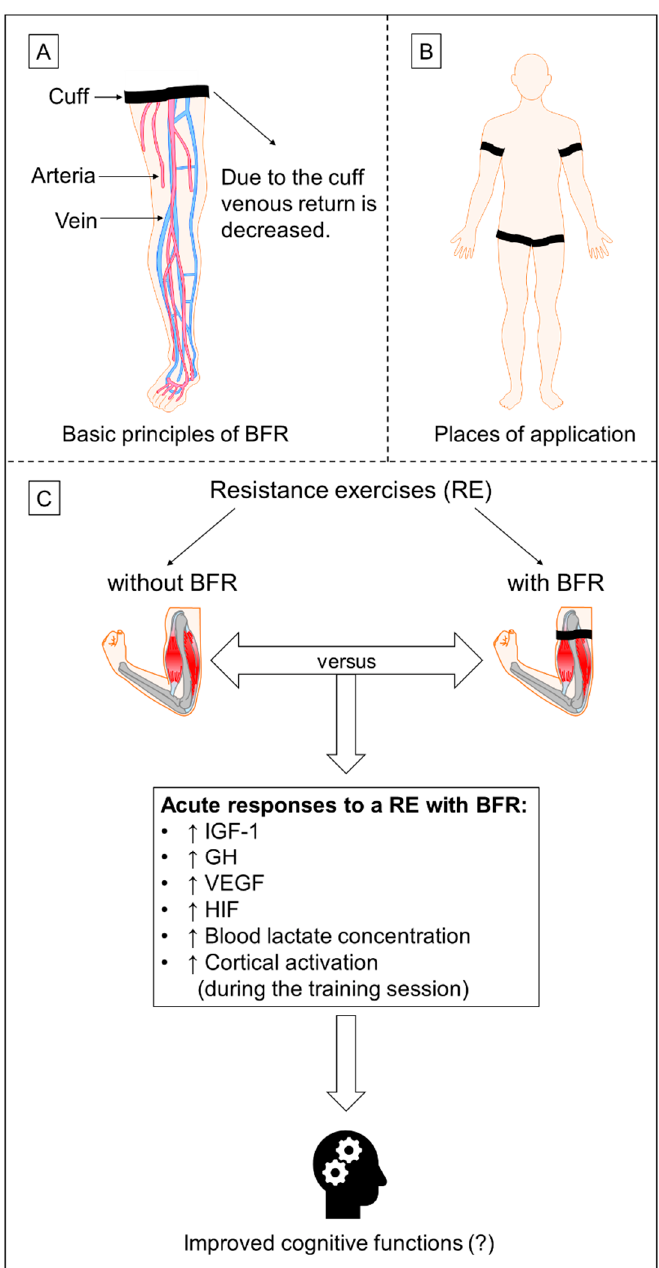
Figure 1. Schematic illustration of ( A ) the basic principles of blood flow restriction, ( B ) the application places of the cuffs for blood flow restriction and ( C ) the possible neurobiological mechanisms of resistance training with blood flow restriction that are likely to contribute to improved cognitive functions; blood flow restriction (BFR), growth hormone (GH), hypoxia-inducible factor (HIF), insulin-like growth factor 1 (IGF-1), resistance training (RE), vascular endothelial growth factor (VEGF).